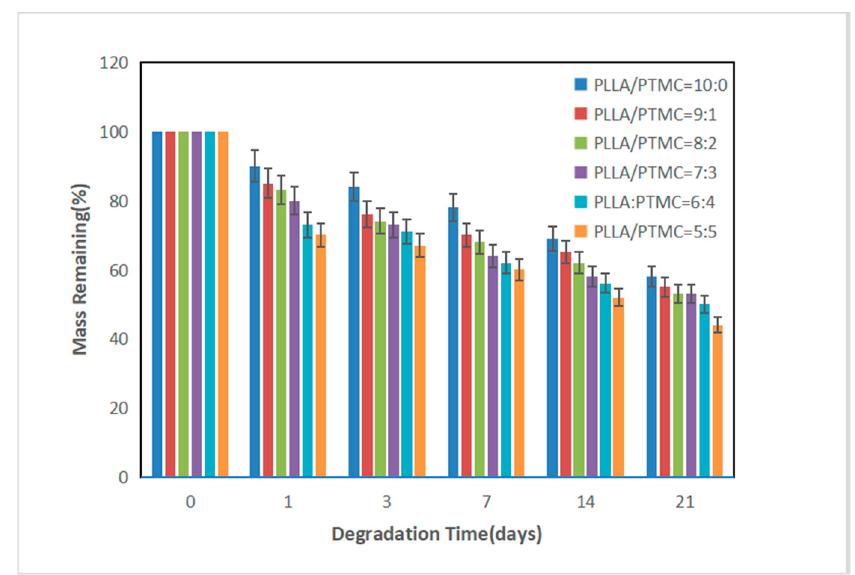
Figure 9. Mass remaining after degradation in PBS. p < 0.05; error bars indicate SD; n = 5 .